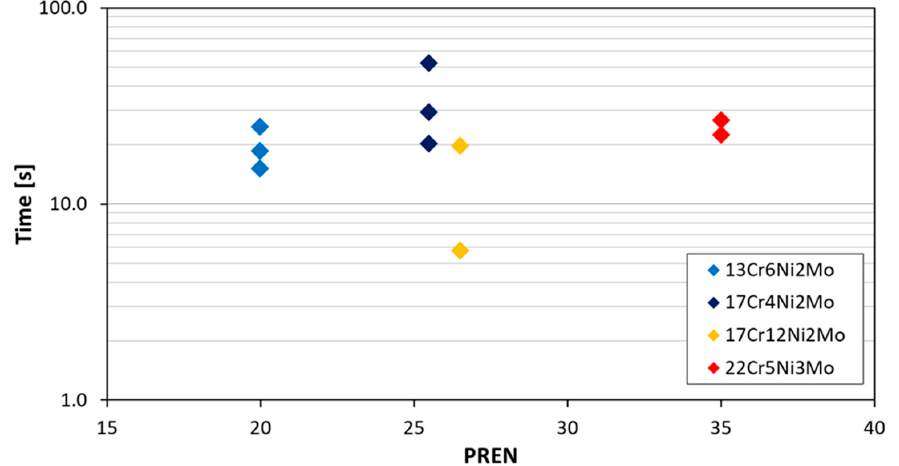
Figure 5. Time from scratching until reaching a current density of 0.01 mA / cm 2 (roughly equal to a corrosion rate of 0.1 mm / year) for investigated alloys in 30,000 ppm Cl – at 30 ◦ C at pH 3 as function of alloying content.